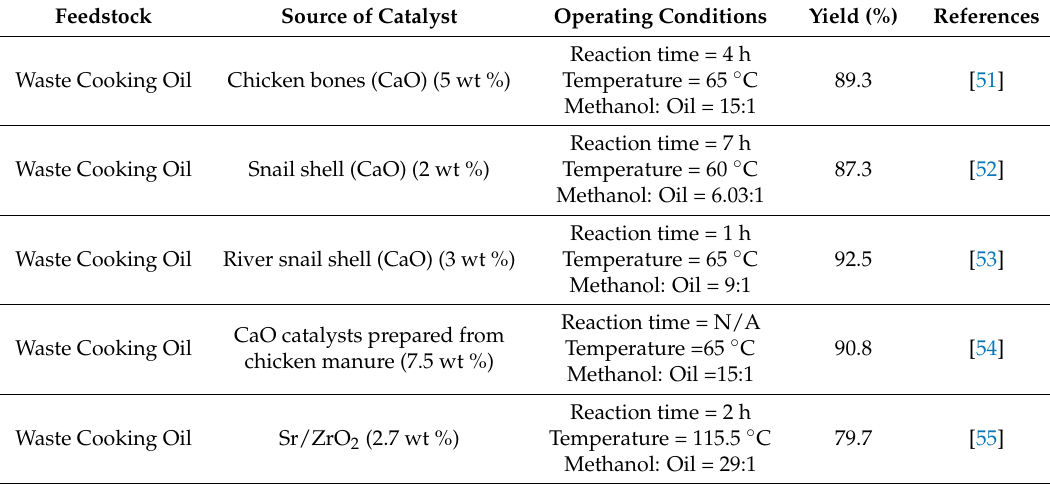
Table 3. Comparison of catalytic performance for transesterification reaction over the CaO catalysts derived from different sources.